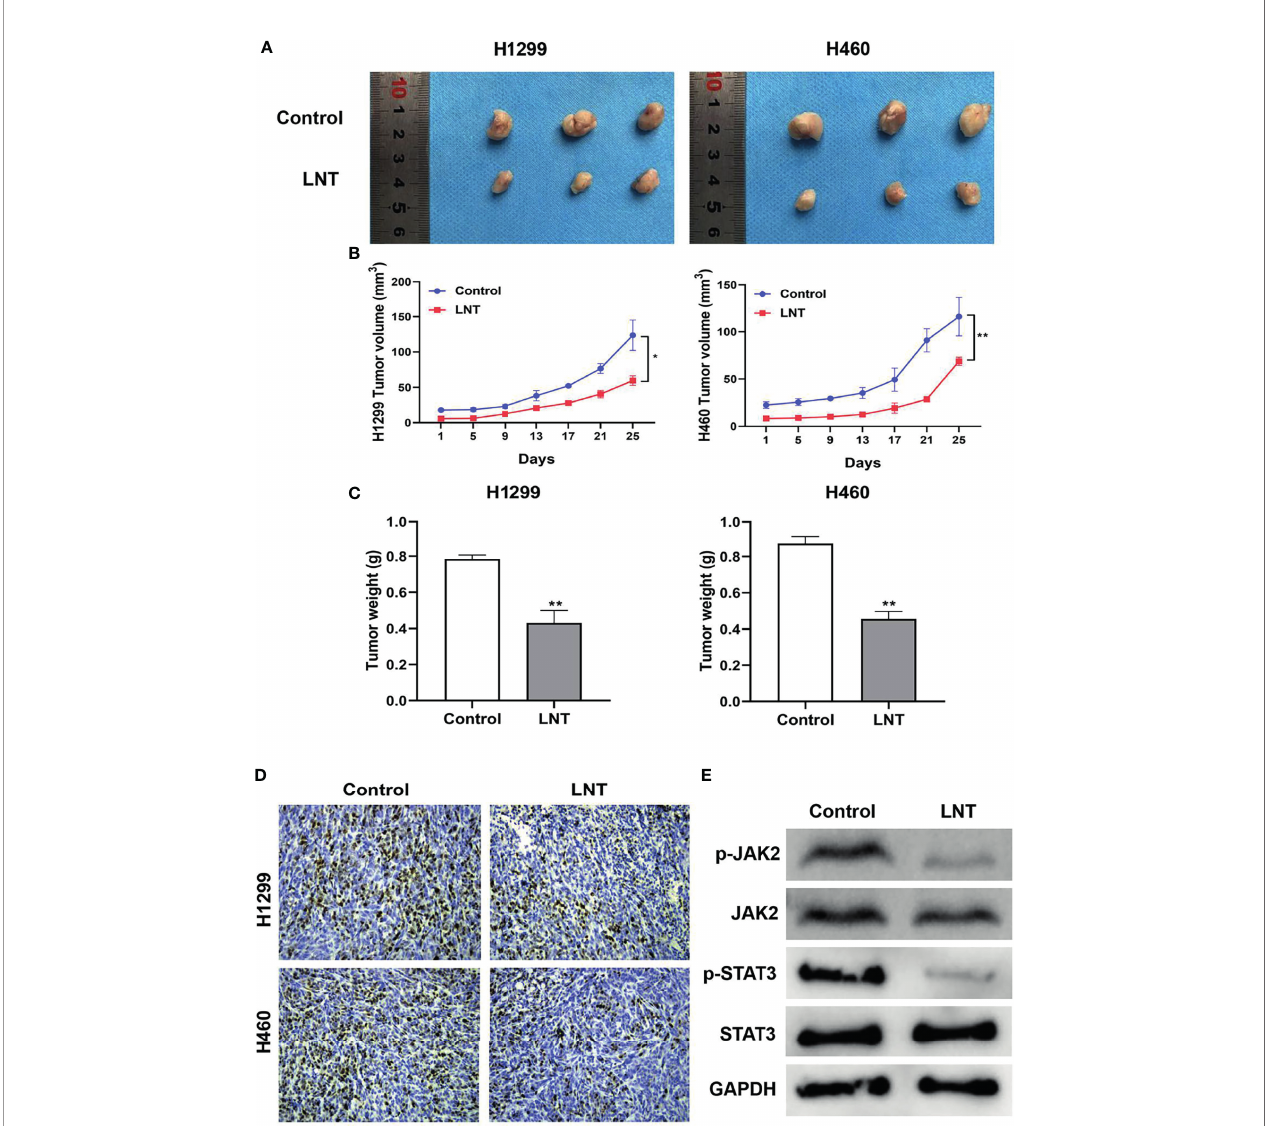
FIGURE 6 | LNT effects on the growth of lung adenocarcinoma in vivo . (A) Tumors of nude mice in each group after inoculating H1299 and H460 cells with tumor; (B) Tumor size of nude mice in individual groups after inoculating H1299 and H460 cells with tumor; (C) Tumor weight of nude mice in individual groups after tumor inoculation in H1299 and H460 cells; (D) IHC used to detect Ki-67 expression in tumor tissues of nude mice in individual groups; (E) JAK2/STAT3 signaling pathway related proteins expression in tumor tissues detected using Western blot. Per group n = 6. *P < 0.05 and **P < 0.01 vs . control